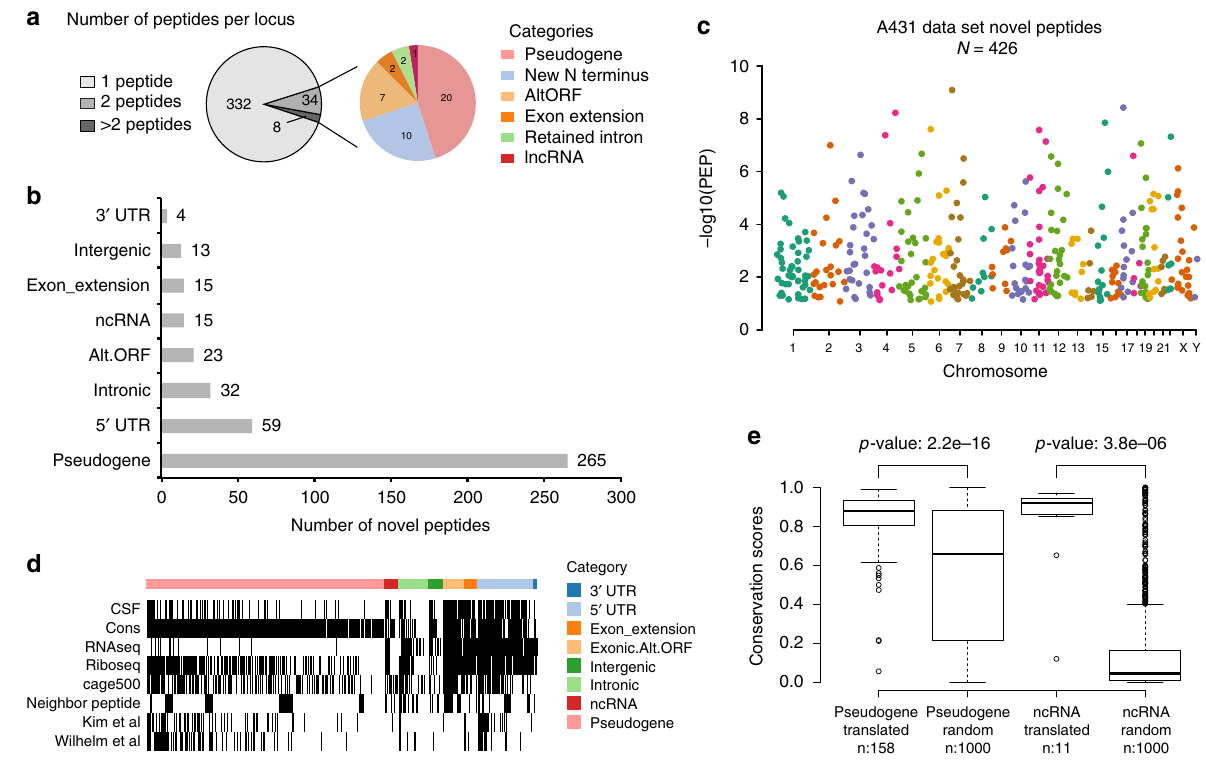
Fig. 4 Unannotated protein-coding loci found in the A431 cells data set. a The left pie chart shows the number of unannotated protein-coding loci supported by one, two, or more peptides (peptides within 10 kb distance were grouped into one locus); the right pie chart shows the different types of unannotated coding events supported by multiple peptides. b Automatic categorization of novel peptides by annovar using RefSeq gene annotation (see “ Methods ” ). c Manhattan plot of novel peptides, where the y -axis represents the peptide ’ s posterior error probability (PEP). d Orthogonal data support for novel peptides, including PhyloCSF coding potential, conservation analysis, A431 cell line RNA-seq reads evidence, ribosome pro fi ling, CAGE (up to 500 bp upstream from peptide location), presence of neighboring peptides (within 10 kb), and whether the peptide was identi fi ed in the draft proteome data of Kim et al. 35 and Wilhelm et al. 21 . Continuous variables were discretized to binary values 0 or 1 for visualization purposes. 10,000 random genomic loci were used to determine the threshold to call if Ribo-seq or CAGE data were supportive or not (see Supplementary Figure 20). e The conservation score (PhastCons 68 score) distribution of pseudogenes and lncRNAs for which peptides were found was compared to that of 1000 randomly selected pseudogenes and lncRNAs. In the box plots, center line corresponds to median, box boundaries correspond to the fi rst and third quartiles (Q1 and Q3), the upper whisker is min(max(x), Q3 + 1.5 × IQR) and lower whisker is max(min(x), Q1 – 1.5 ×